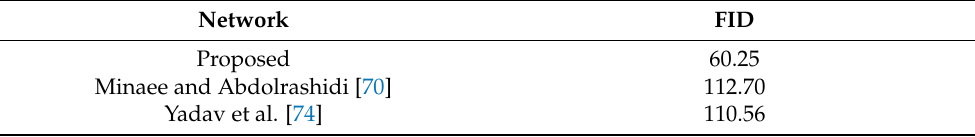
Table 4. Frechet Inception Distance (FID) score of CASIA-Iris-Thousands database.